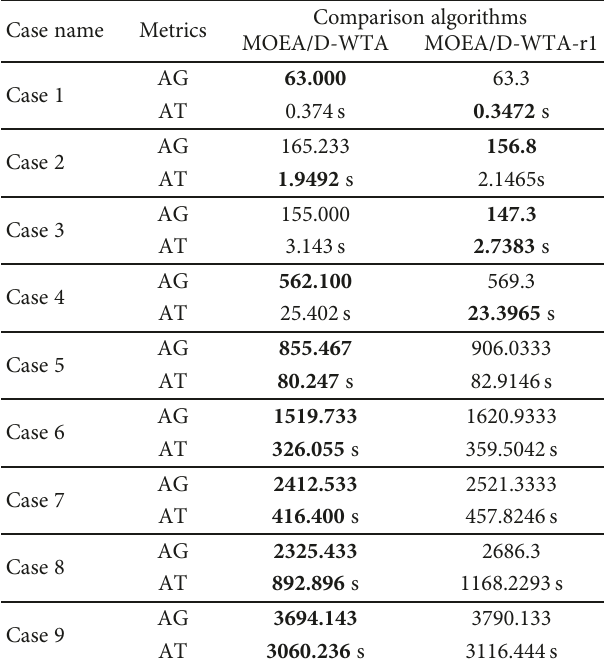
Table 8: Results of AG and AT for MOEA/D-WTA and MOEA/D- WTA-r2.